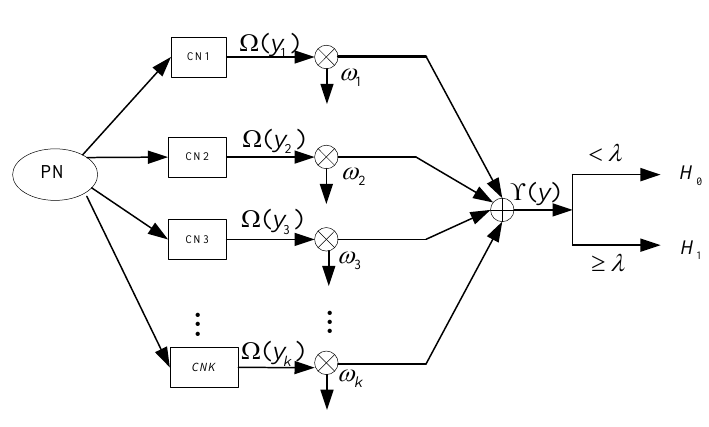
Figure 1. Frame structure of CSN.